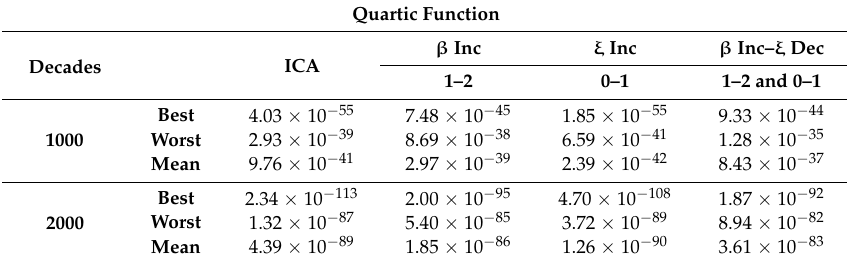
Table 2. Quartic